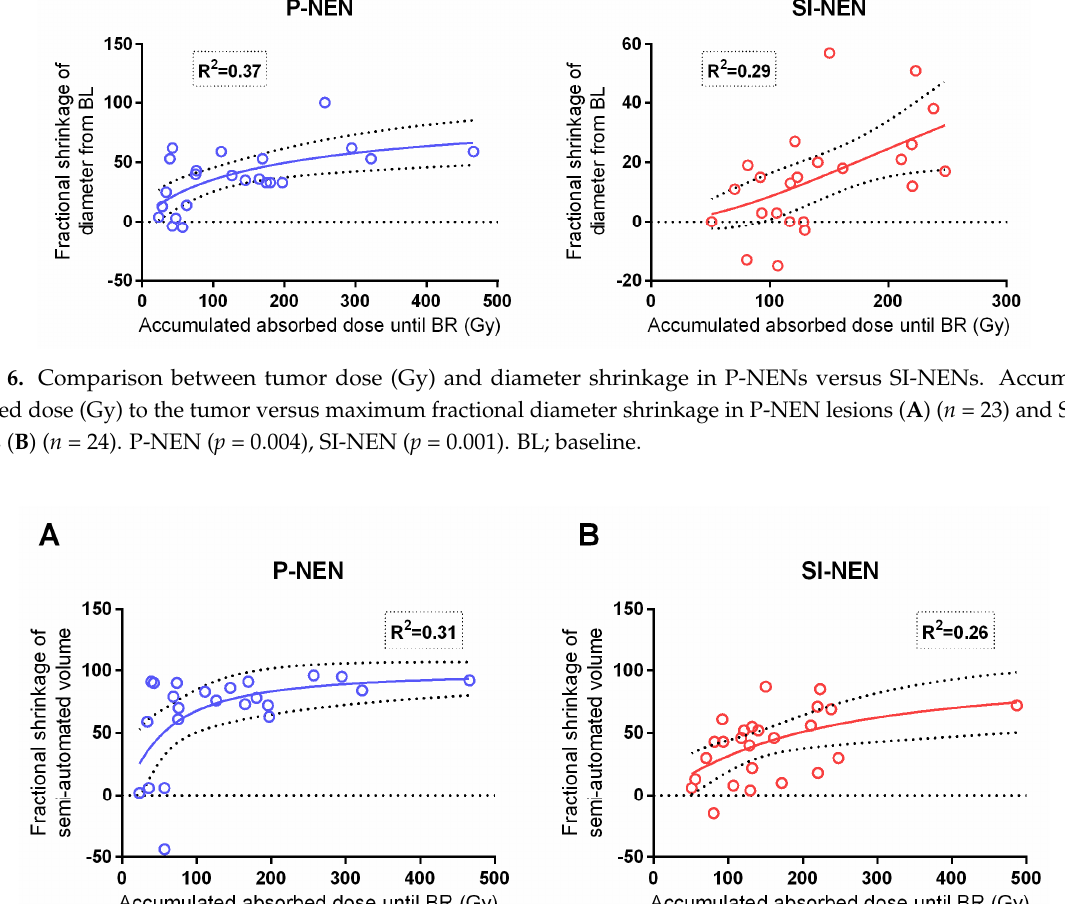
Figure 7. Comparison between tumor dose (Gy) and semi-automated volume (cm 3 ) shrinkage in P-NENs versus SI-NENs. Accumulated absorbed dose (Gy) to the tumor versus the maximum fractional shrinkage of semi-automated volume (cm 3 ) in P-NENs ( A ) ( n = 23) and SI-NENs ( B ) ( n = 25). P-NEN ( p = 0.03), SI-NEN ( p = 0.02). BR: best response.